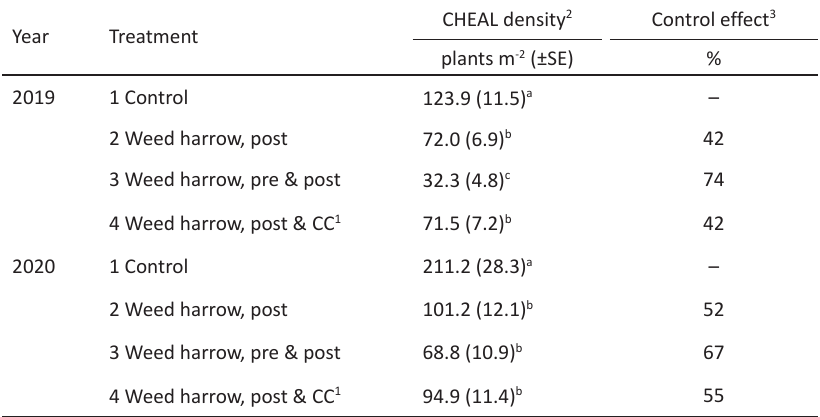
Table 3. Effect of weed harrowing treatments on the density of C. album (LSMeans with standard error). Assessments were made approximately two weeks after post-emergence weed harrowing in 2019 and 2020 (see Table